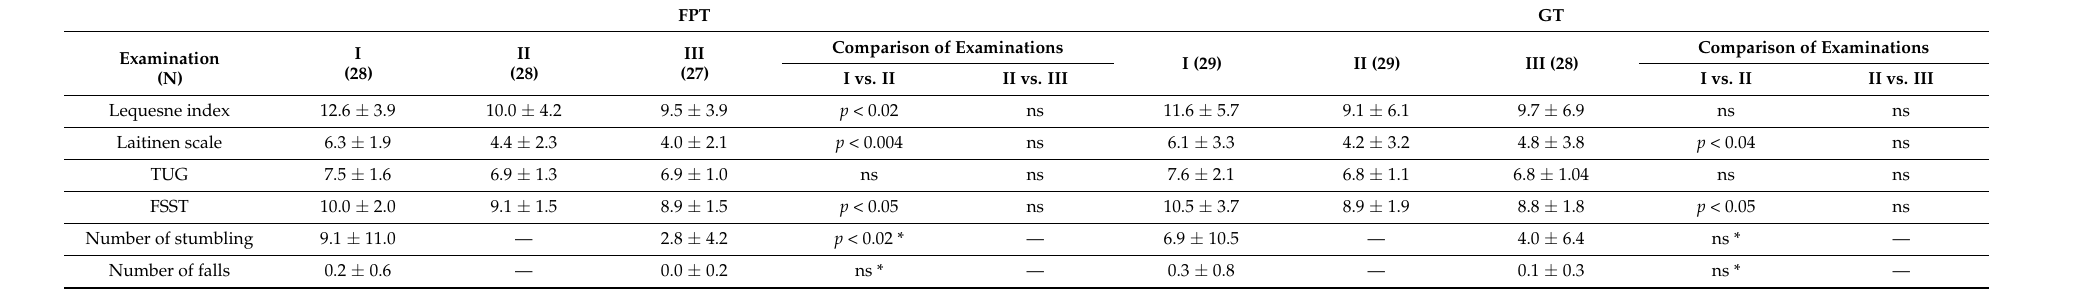
Table 1. Clinical data in two groups: FPT and GT.